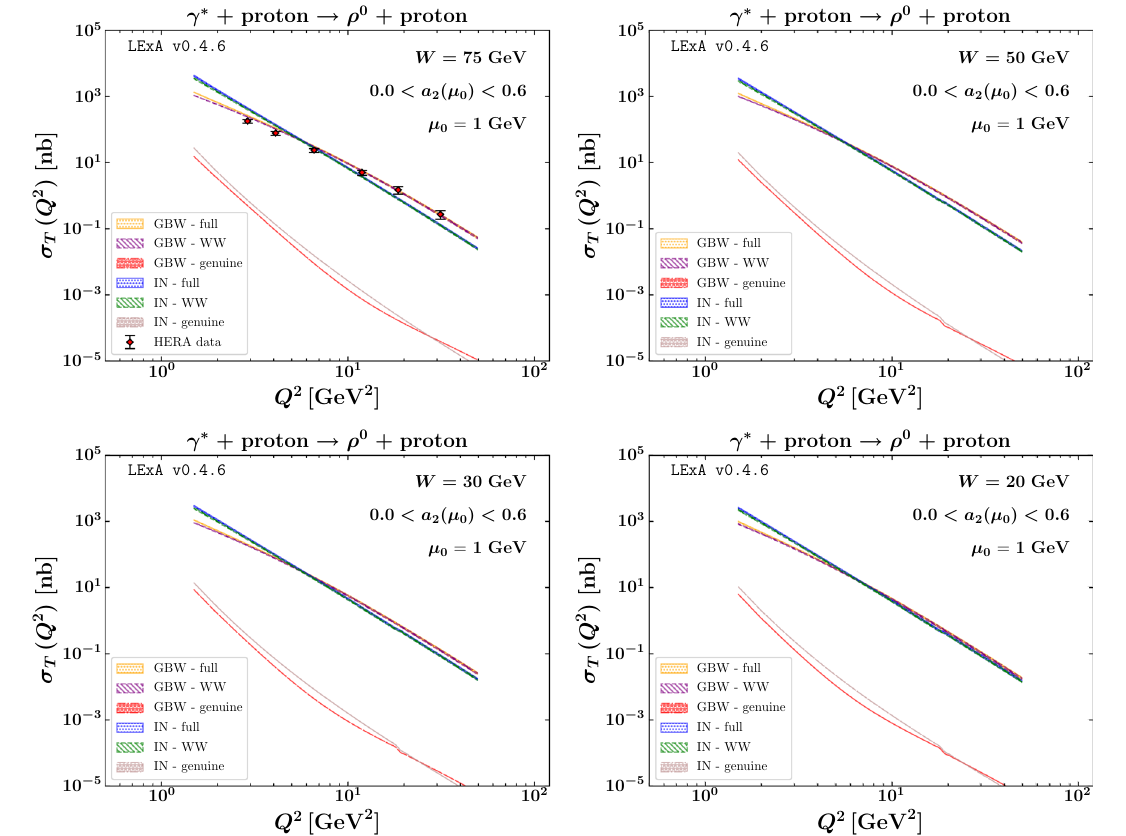
Fig. 7 Q 2 -dependence of the transversely polarized cross section, σ T , for GBW and IN UGD models, at W = 75 GeV together with the HERA data (left upper panel) and at W = 20 , 30 , 50 GeV relevant